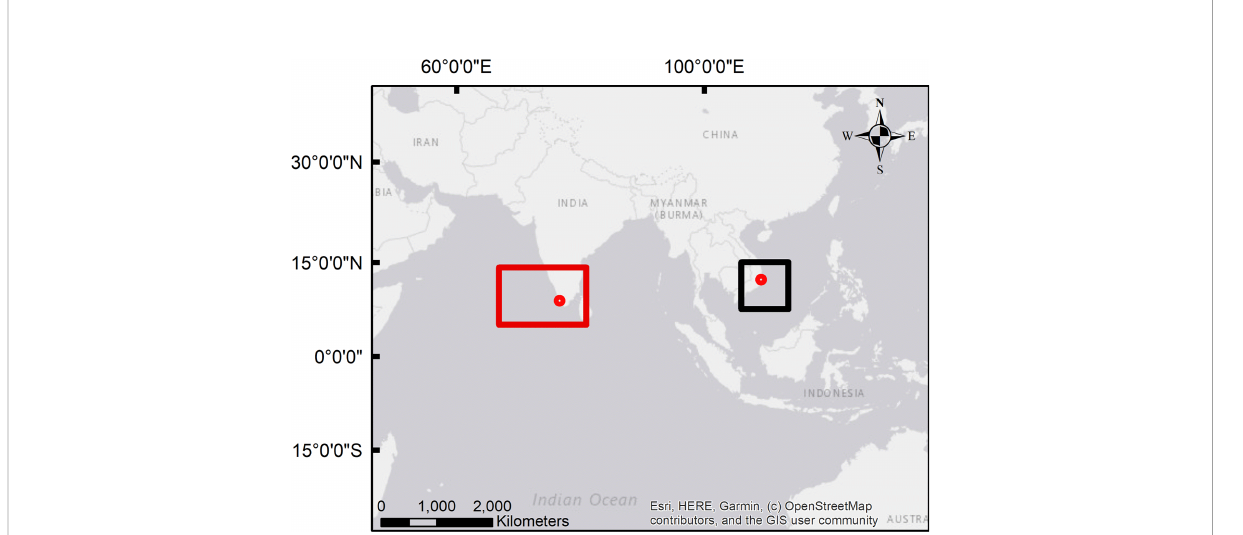
FIGURE 1 Map showing the location of the processing plants (red circles) and the estimated catchment areas of the samples from the Indian Ocean (red rectangular) and the Paci fi c Ocean (black square); details about the potential catchment areas (outbreak trace-back) are provided in Loef fl